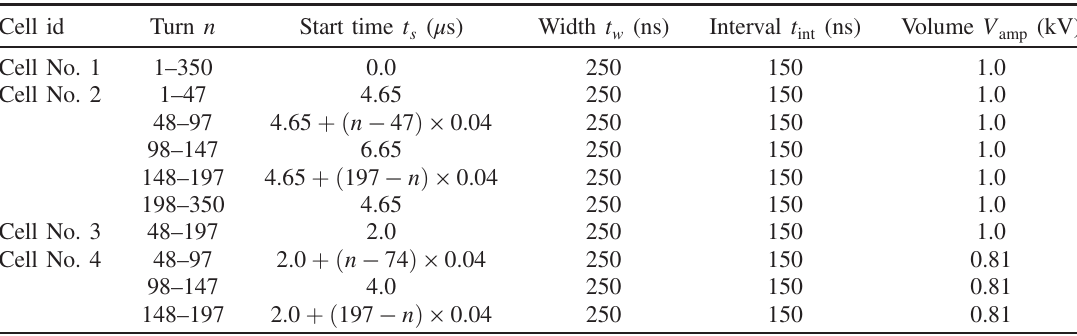
TABLE II. Trigger timings and amplitudes of the acceleration pulse in the